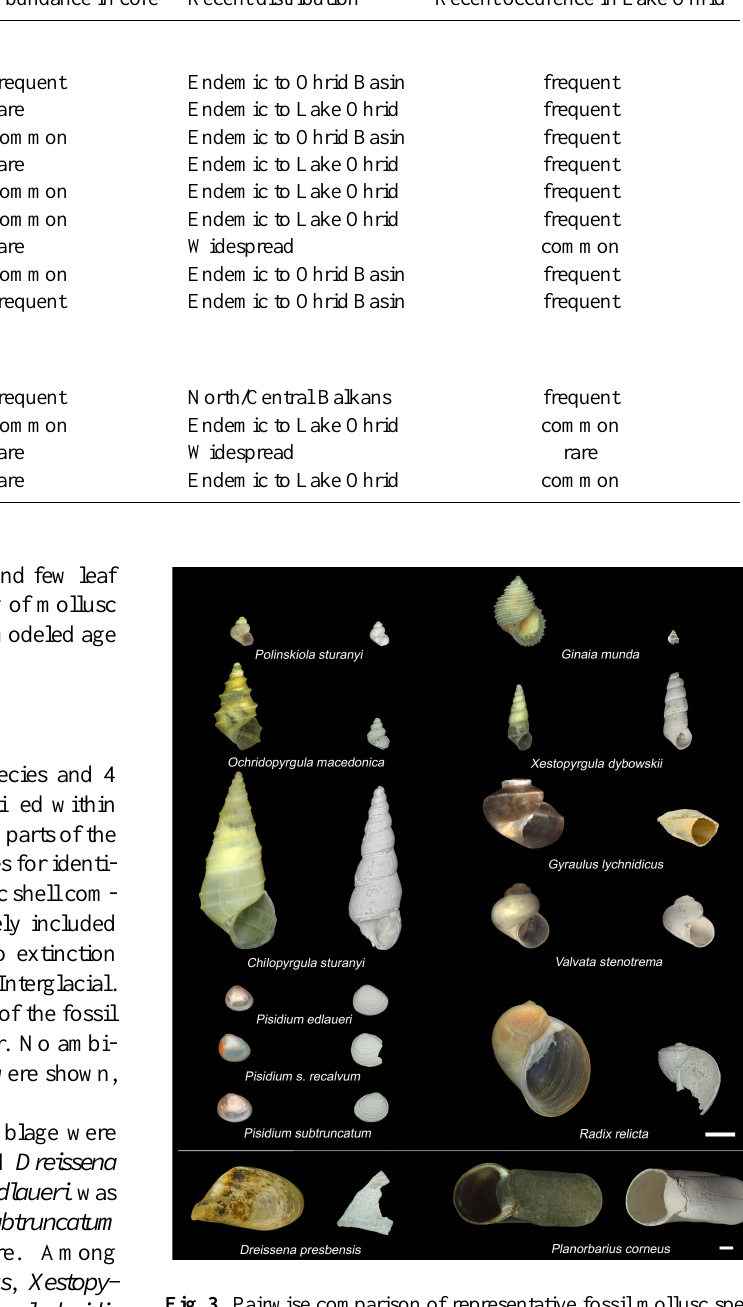
Fig. 3. Pairwise comparison of representative fossil mollusc speci- mens of core Co1200 (left specimens) and recent analoga from Lake Ohrid (right specimens). Scale bar is